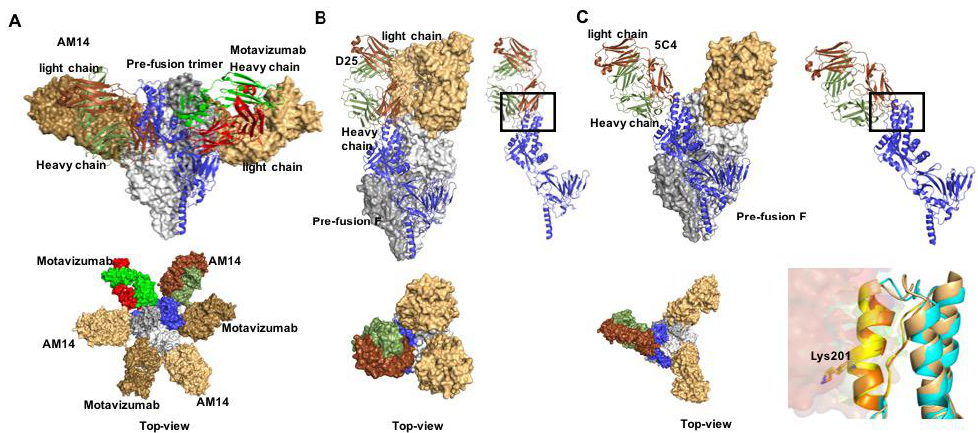
Figure 3. Prefusion RSV F in complex with nAbs. ( A ) Docking poses of motavizumab (red and green) and AM14 (brown and smudge), bound to prefusion F. Both nAbs recognize quaternary epitopes (PDB 4ZYP) and bind the trimer alternatively (lower panel). ( B, C ) nAbs D25 and 5C4 (PDB 4JHW and 5W23, respectively) docked to the apex region of the prefusion RSV F protein trimer (antigenic site Ø). ( D ) Antigenic site Ø shown in orange and yellow. Mutation at position 201 mediates resistance.